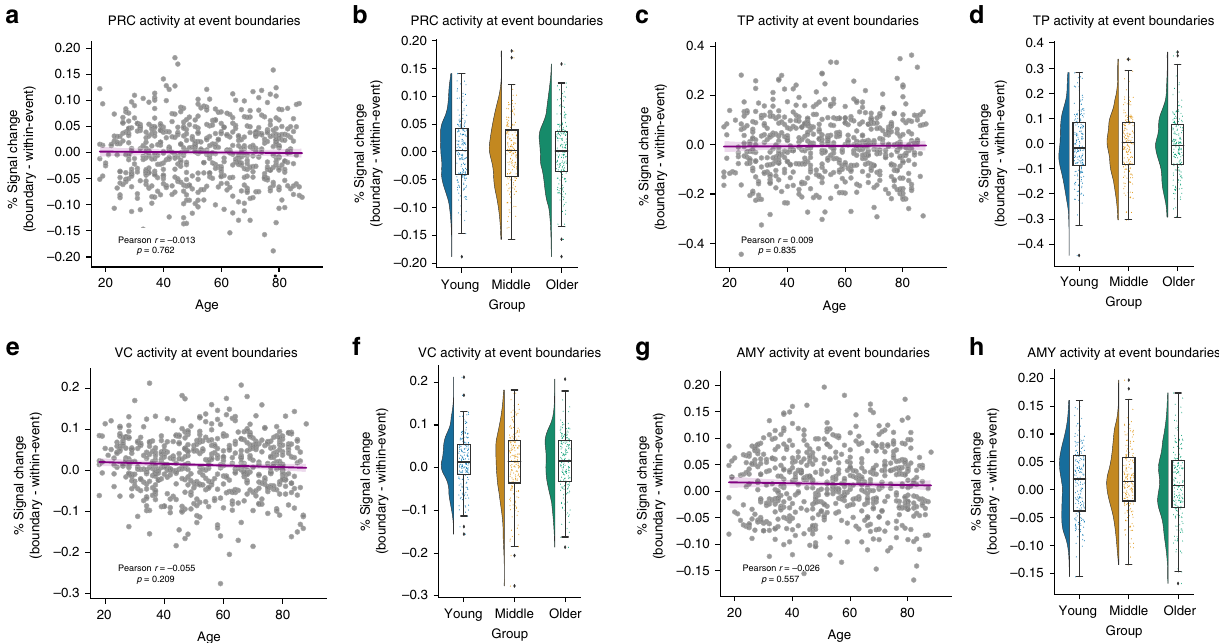
Fig. 6 Anterior-temporal regions and visual cortex do not show age-related changes. Boundary-evoked responses were not observed in a , b perirhinal cortex or c , d temporal poles. Boundary-evoked responses were observed in e , f visual cortex and g , h amygdala, but these did not signi fi cantly change with age. (Correlations were assessed via Person ’ s r . Raincloud plots depict data distributions across groups, with box components displaying median values and data quartiles. N = 546 for correlations, N = 182 per group for groupwise comparisons, examined over a single experiment).